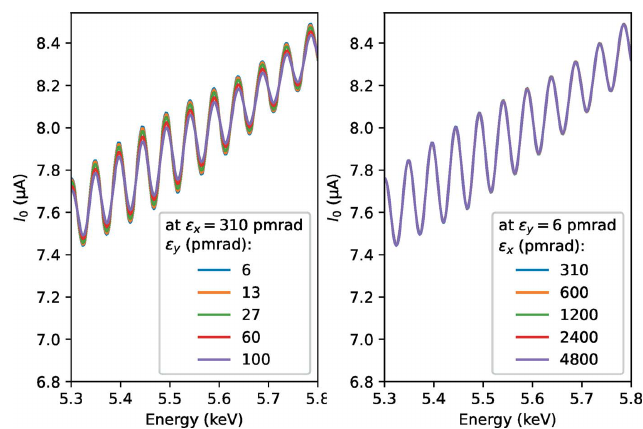
Figure 6 Calculated wiggler spectra at various vertical (left) and horizontal (right) e-beam emittances.